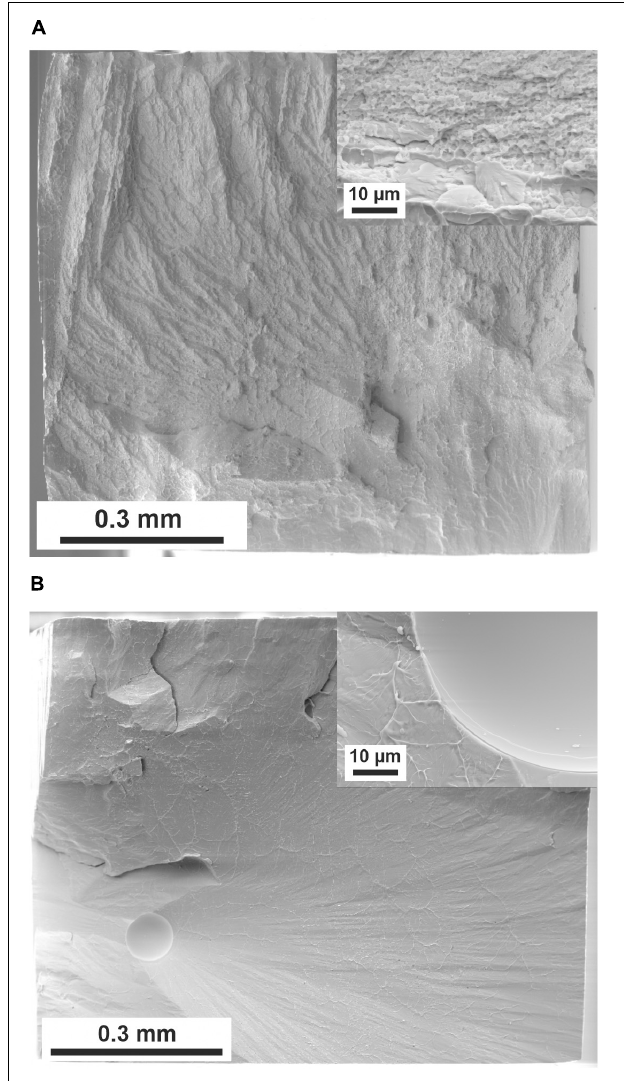
FIGURE 6 | Tensile tests of samples of routes A and B in air. (A) Exemplary stress strain curves and (B) boxplots of the fracture stress ( n = number of tested samples).